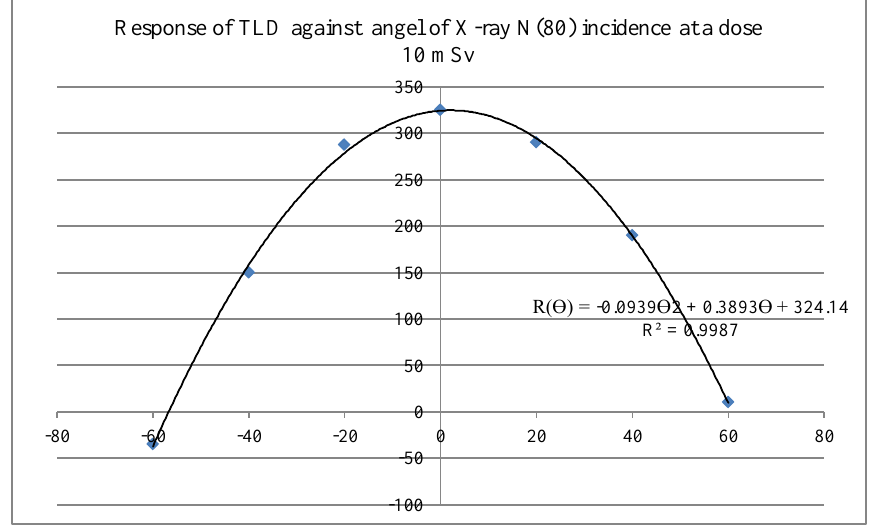
Figure 7. Response of TLD against x-ray N (80)